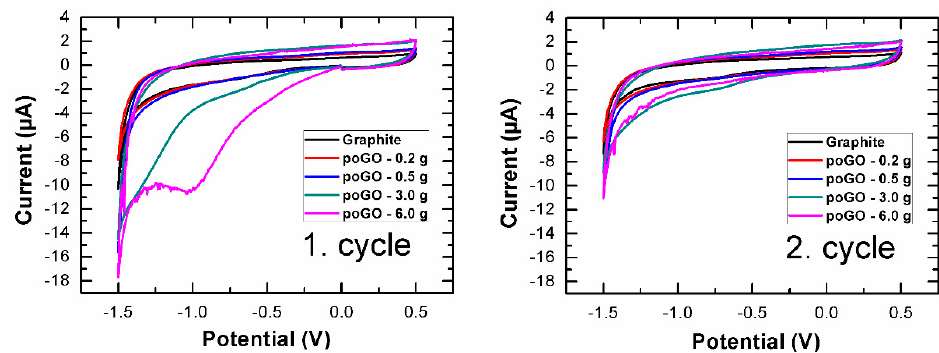
Figure 6. Measurements of inherent electrochemistry in first cycle (left) and second cycle (right).